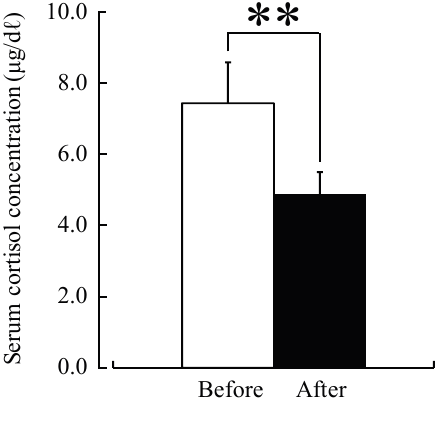
Figure 3. Effect of forest therapy on urinary adrenaline levels. N = 9, mean ± standard error. * p < 0.05, paired t -test.